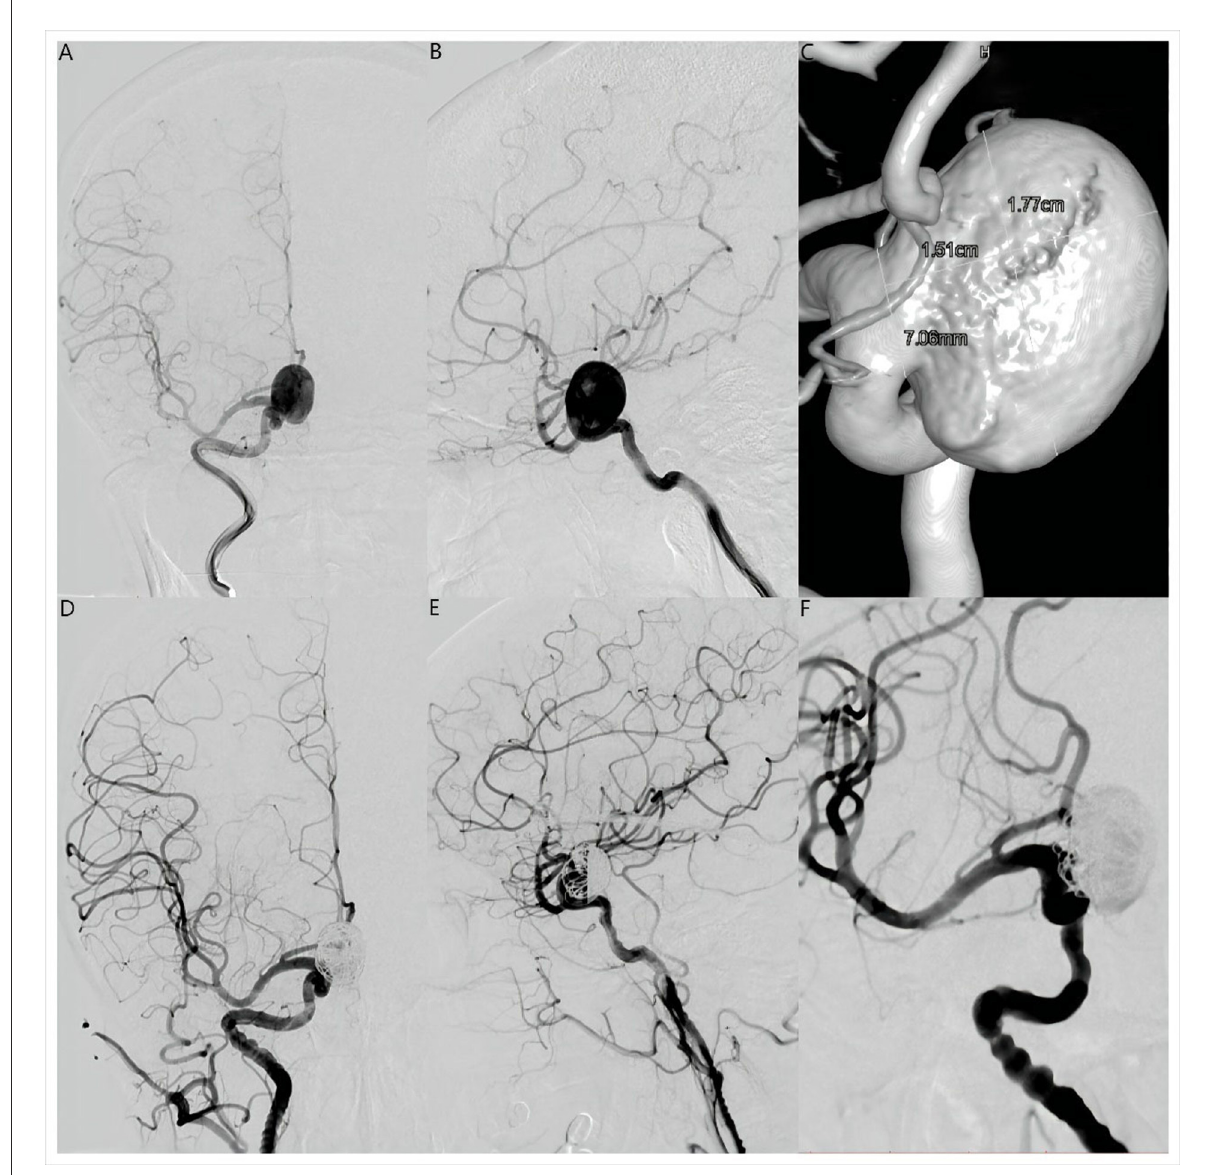
FIGURE1 Anteroposterior (A) and lateral (B) digital subtraction angiography views and three-dimensional reconstruction angiography (C) revealed a large saccular right supraclinoid internal carotid artery aneurysm. Maximum diameter was 17.7mm and the aneurysm neck was 7.06mm. Anteroposterior (D) , lateral (E) , and operating position (F) angiographic views immediately after placement of a Pipeline Flex embolization device (Medtronic, Dublin, Ireland) showed contrast filling in the aneurysm lumen with entry remnant (O’Kelly-Marotta Grade